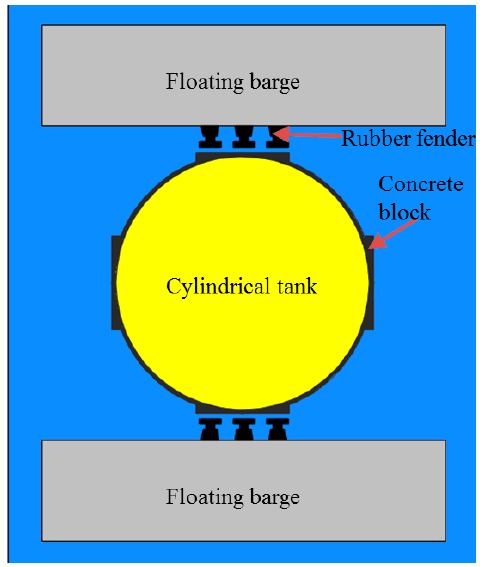
Figure 33. Single hull tank enclosed by floating barges.